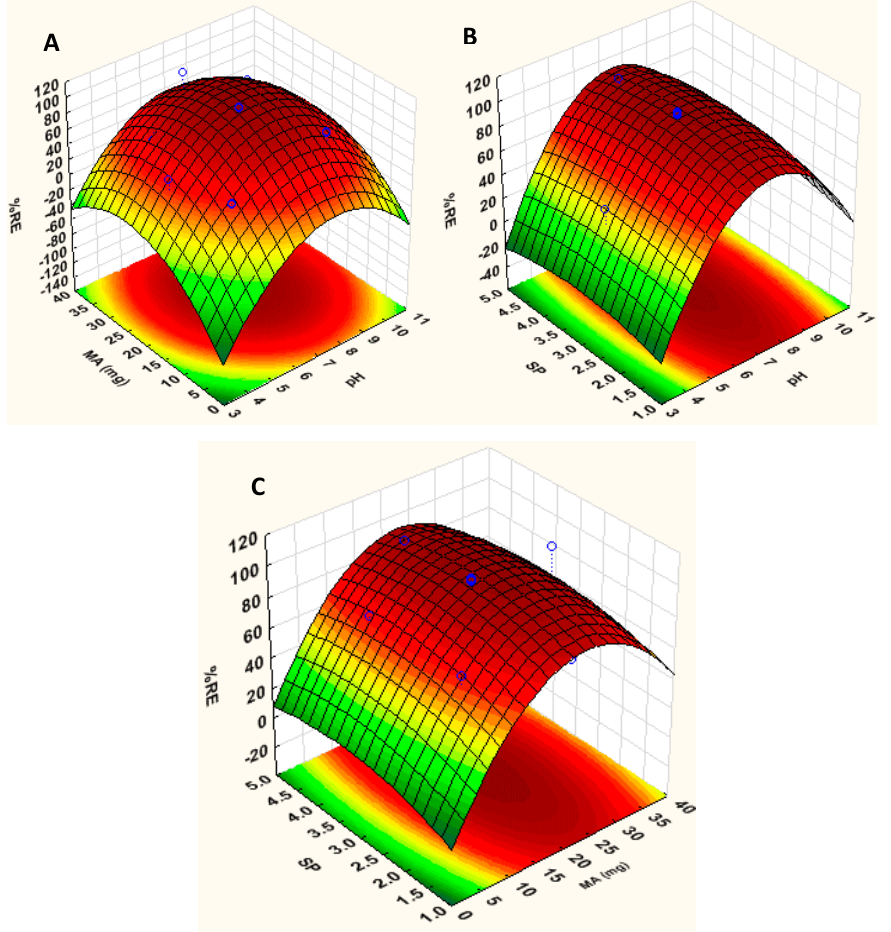
Figure 5. The 3D surface response plots describing the interactions of the parameters investigated. ( A ) interaction between sample pH and mass of adsorbent (MA); ( B ) interactions between sonication power (SP) and sample pH and ( C ) interactions between SP and